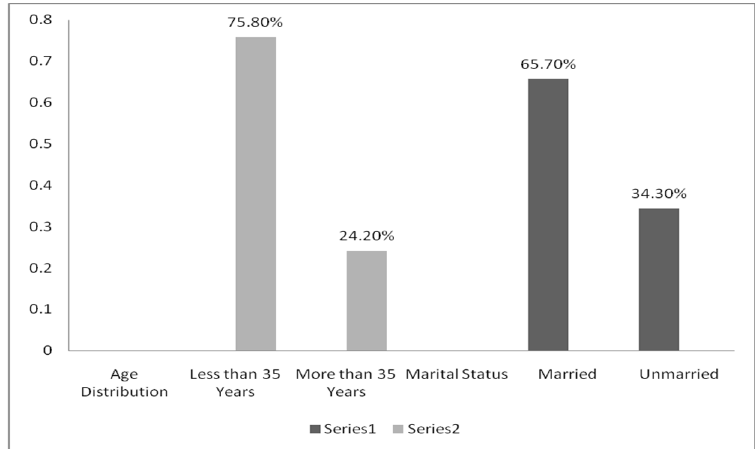
Figure 1: Socio-demographic characteristics of the respondents: Age and marital Status